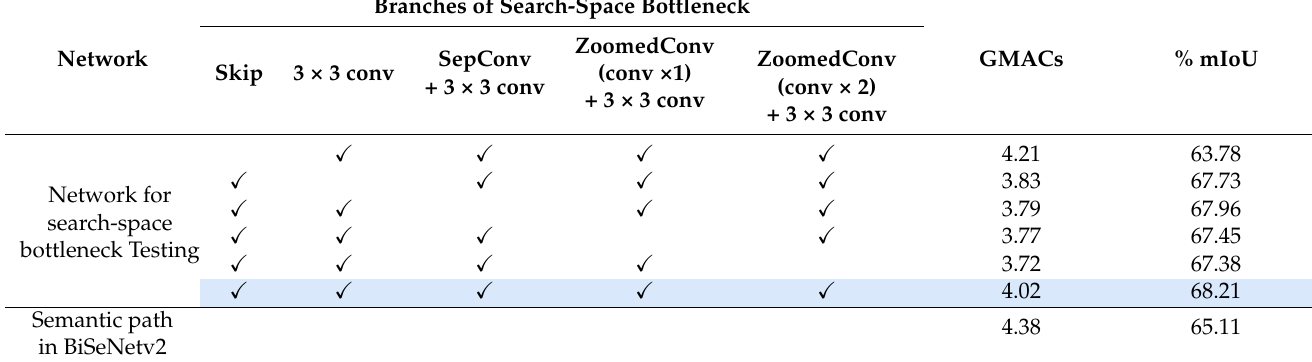
Table 5. Ablation experiments for the search-space bottleneck. Notation: Skip denotes skip connec- tion; conv denotes convolution; SepConv denotes depth-wise separable convolution; 3 × 3 denotes kernel